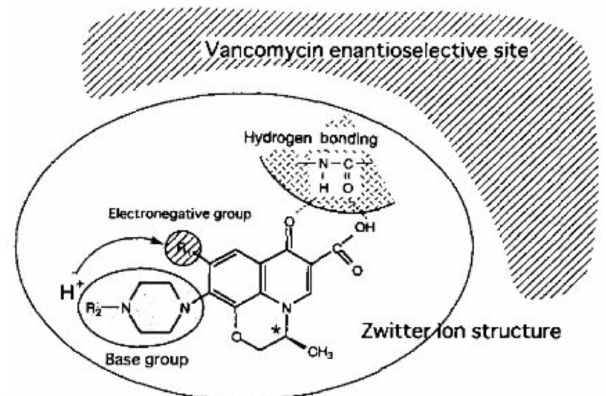
Figure 2. Speculative diagram depicting the possible separation mechanism between vancomycin as CS and quinolone carboxylic acids. The figure is reproduced from Arai et al. [29] with permission from